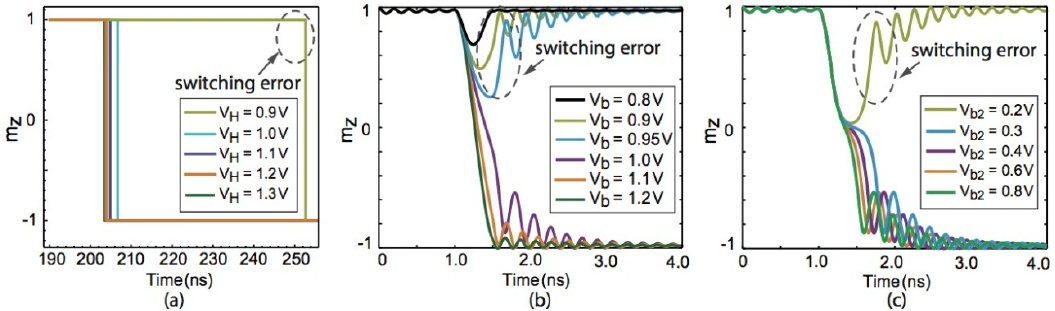
Figure 4. ( a ) STT ‐ MTJ switching: low bias voltage may cause switching failure (e.g., V H = 0.9 V). ( b ) Precessional VCMA is implemented with a different V b amplitude and 0.5 ns pulse duration. A minimum 1 V V b is required to successful switch the MTJ. A decreased V b amplitude could lead to longer switching latency. ( c ) Based on the setup of Figure 3a, at least 0.3 V V b2 is required to complete STT ‐ assisted precessional VCMA switching [25].